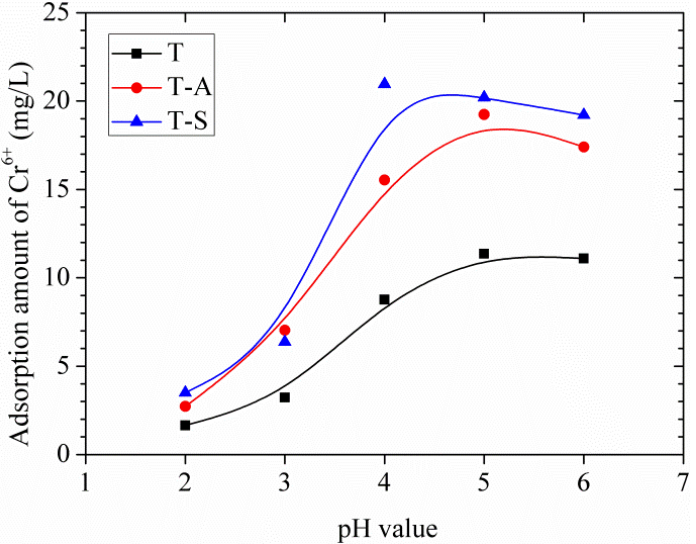
Figure 8. Effects of initial pH on adsorption amount of Cr(VI).